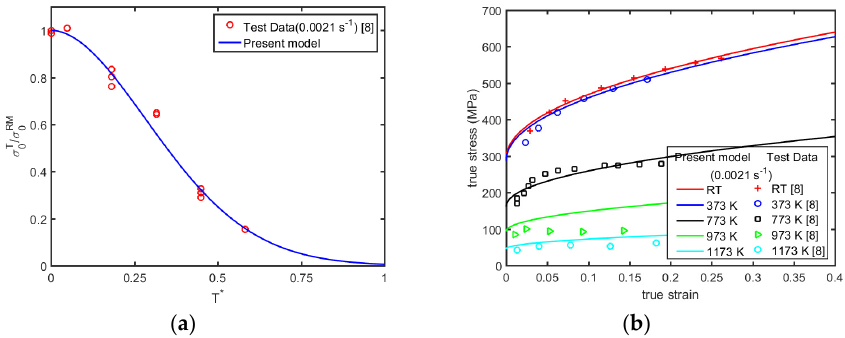
Figure 13. Comparison of the present model predictions with the compression test data for Q235 mild steel. ( a ) σ 0 T / σ 0 Ta versus T * at a plastic strain of yield stress under strain rate of 0.0021 s − 1 ; and ( b ) true stress-true strain curves at elevated temperatures.